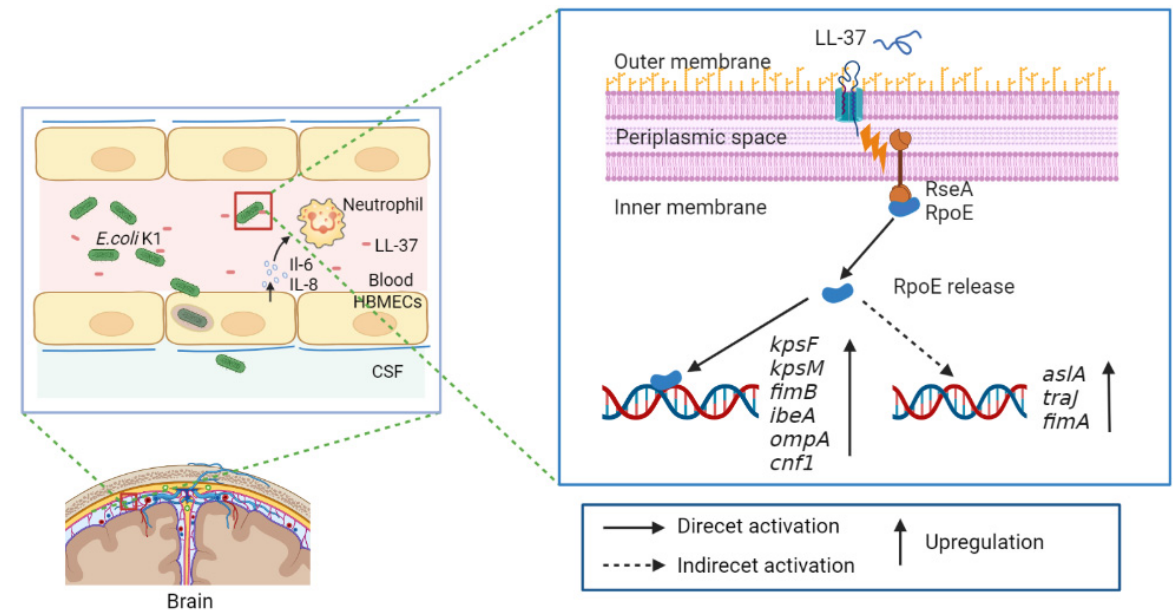
Figure 8. Model of the regulatory pathway of RpoE-mediated cationic antimicrobial peptide-de- pendent signaling in E. coli